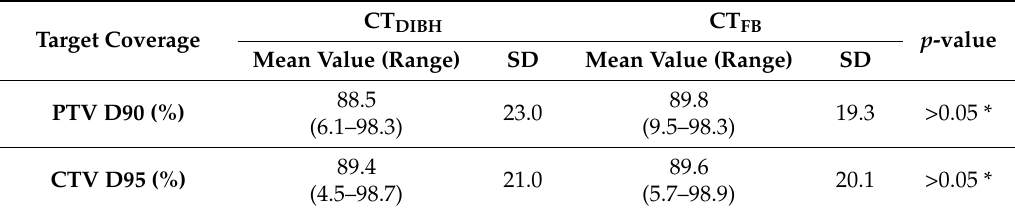
Table 3. Difference in PTV D90 (%) and CTV D95 (%) across the FB and DIBH